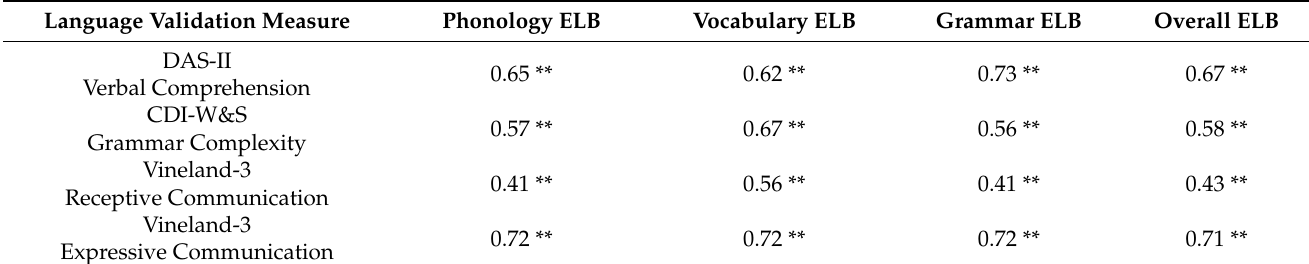
Table 4. Spearman Rank Correlations between Expressive Language Benchmarks and Language Validation Measures.